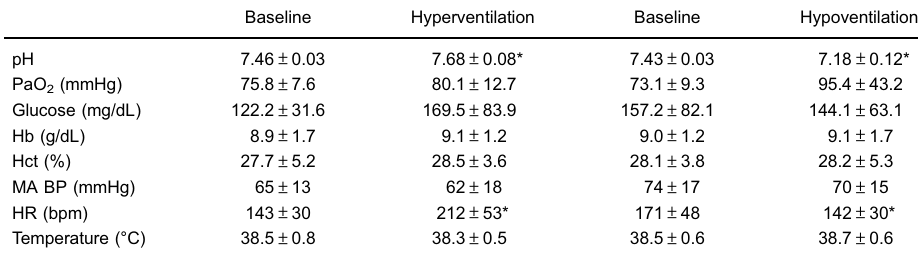
Table 2. Pre- and post-intervention values of assessed variables.